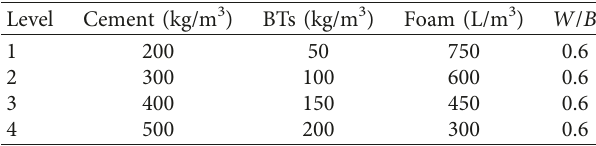
Table 2: Chemical compositions of the BTs and cement.